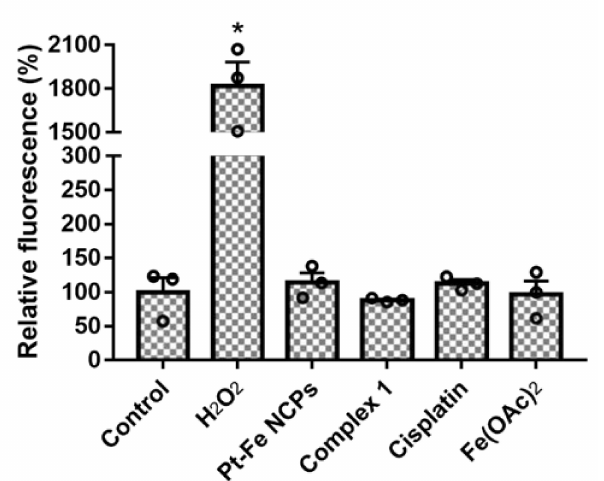
Figure 5. Determination of total ROS production in GL261 cells after 24 h of treatment with cisplatin, complex 1 and Pt-Fe NCPs at IC 50 concentration concentrations, along with Fe(OAc) 2 (100 µ M), H 2 O 2 (100 µ M), or vehicle (control). Columns represent the mean fluorescence of oxidized DCFCDA. Data are expressed as means ± SE of three independent experiments. * denotes p <